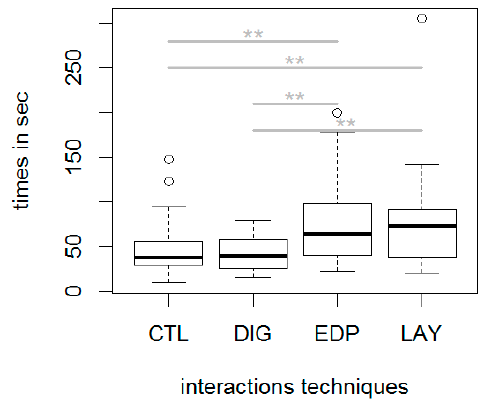
Figure 10. Orientation task duration per interaction technique. DIG and CTL were quicker than LAY and EDP to estimate direction relationships between elements. (** p < 0.01).